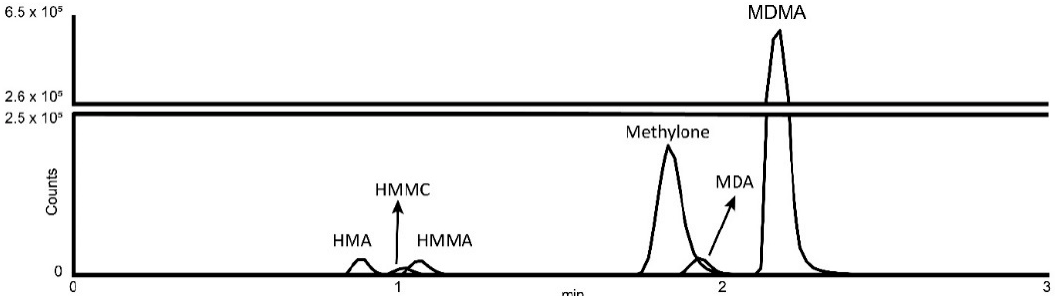
Figure 1. Extracted ion chromatogram of methylone, MDMA and their metabolites. Abbreviations: HMMC, 4-hydroxy-3methoxymethcathinone; MDMA, 3,4-methylendioxymethamphetamine; MDA, 3,4-methylendioxyamphetamine; HMA, 4-hydroxy-3-methoxyamphetamine; HMMA, 4-hy- droxy-3methoxymethamphetamine.